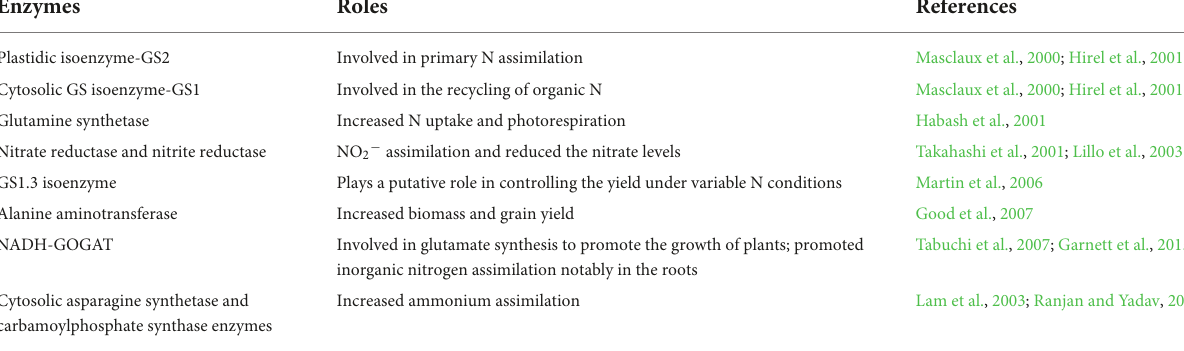
TABLE 2 Nitrogen use efficiency regulating enzymes and their specific roles in plants.